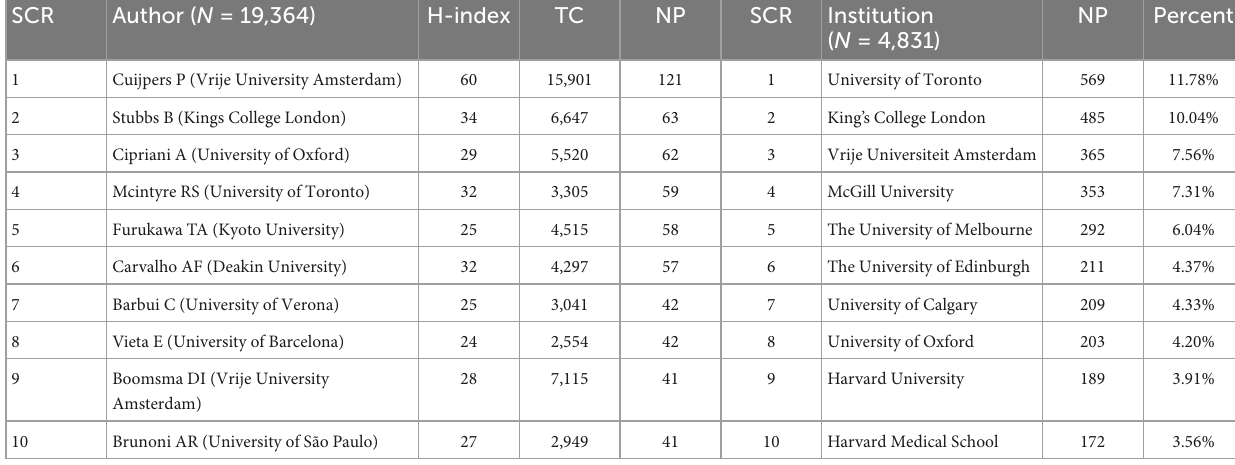
TABLE 2 Top 10 most active authors contributing to MDD-related SR/MA. SCR